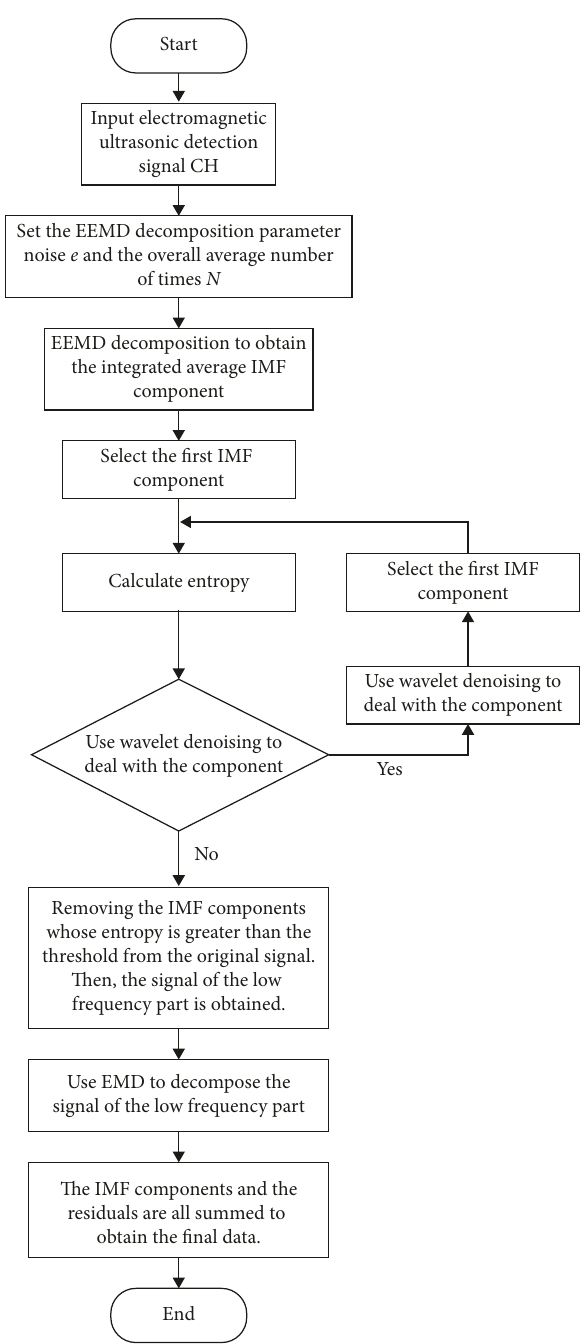
Figure 4: Improved method to handle